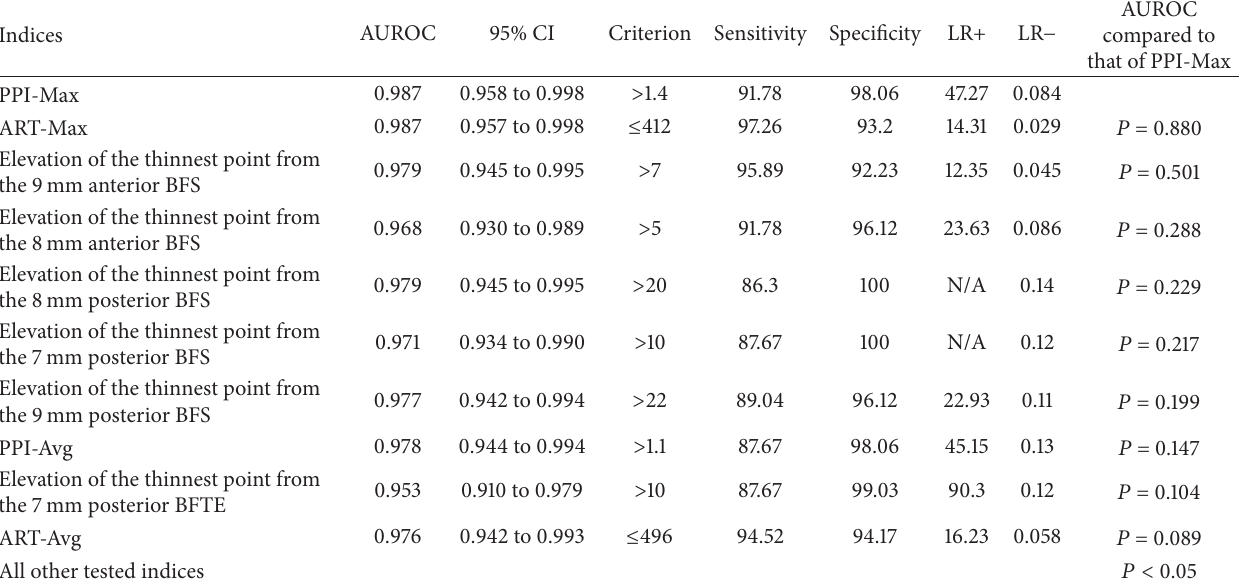
Table 3: The indices with highest